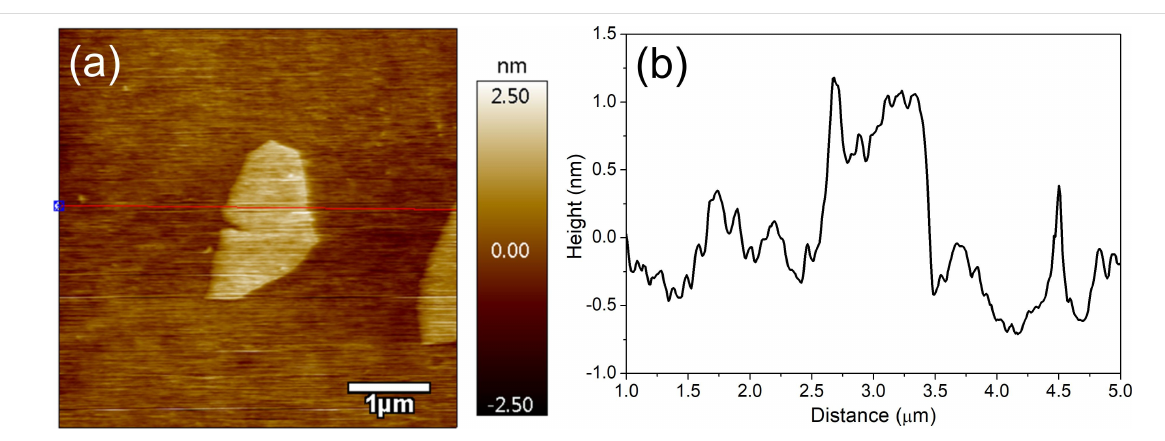
Figure 2: (a) AFM image and (b) AFM height image of the selected GO flake